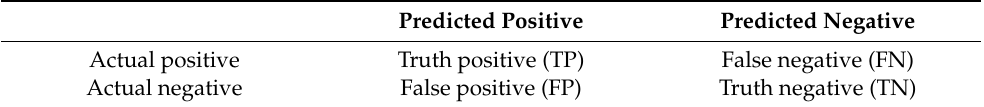
Table 3. Confusion